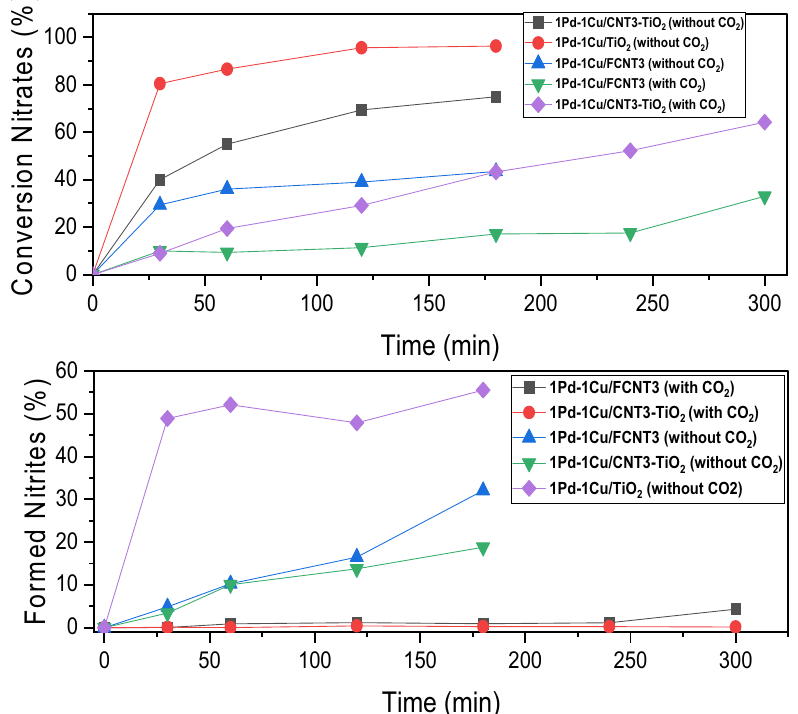
Figure 17: EDX pattern of 4Pd –